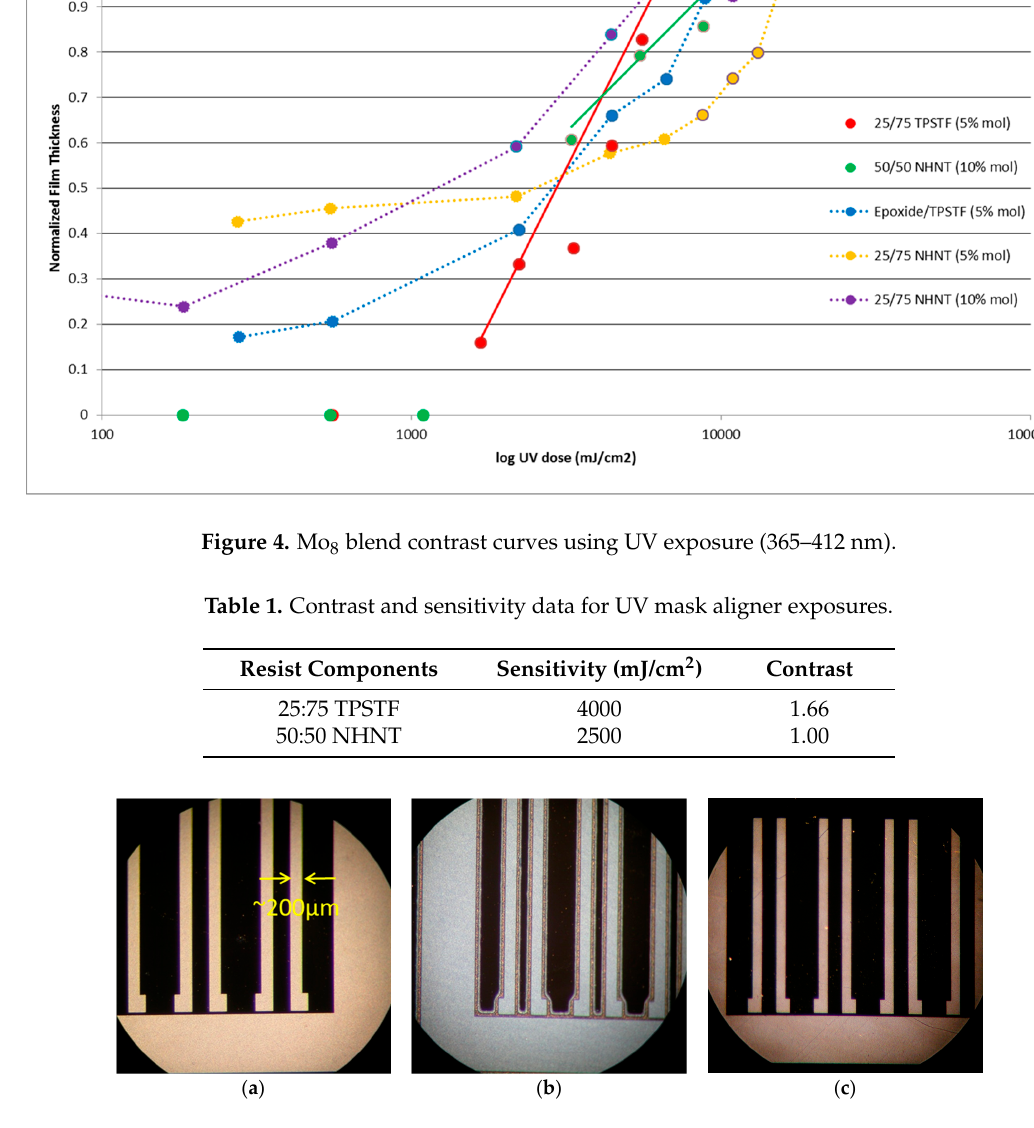
in Figure 4. Two mixtures—25:75 TPSTF and 50:50 NHNT—as mentioned above, showed “optimal”